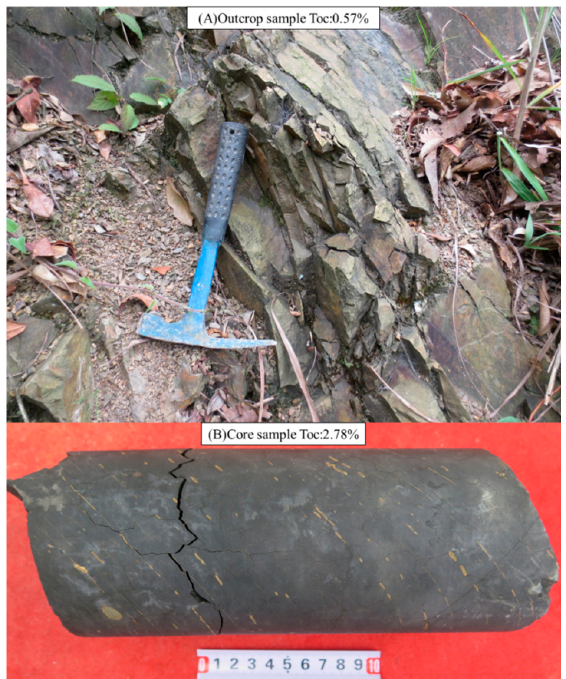
Figure 1. ( A ) The characteristics of an outcrop sample of Xinkailing-formation shale; ( B ) the characteristics of a core sample of Xinkailing-formation shale. (The location of outcrop sample and core sample can be seen in Figure 2).